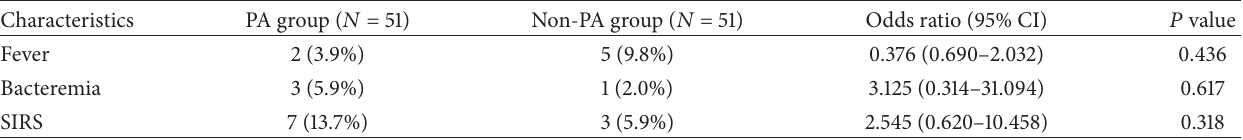
Table 4: Outcome of propensity score-matched post-SEMS insertion fever, SIRS, and bacteremia between PA and non-PA groups.